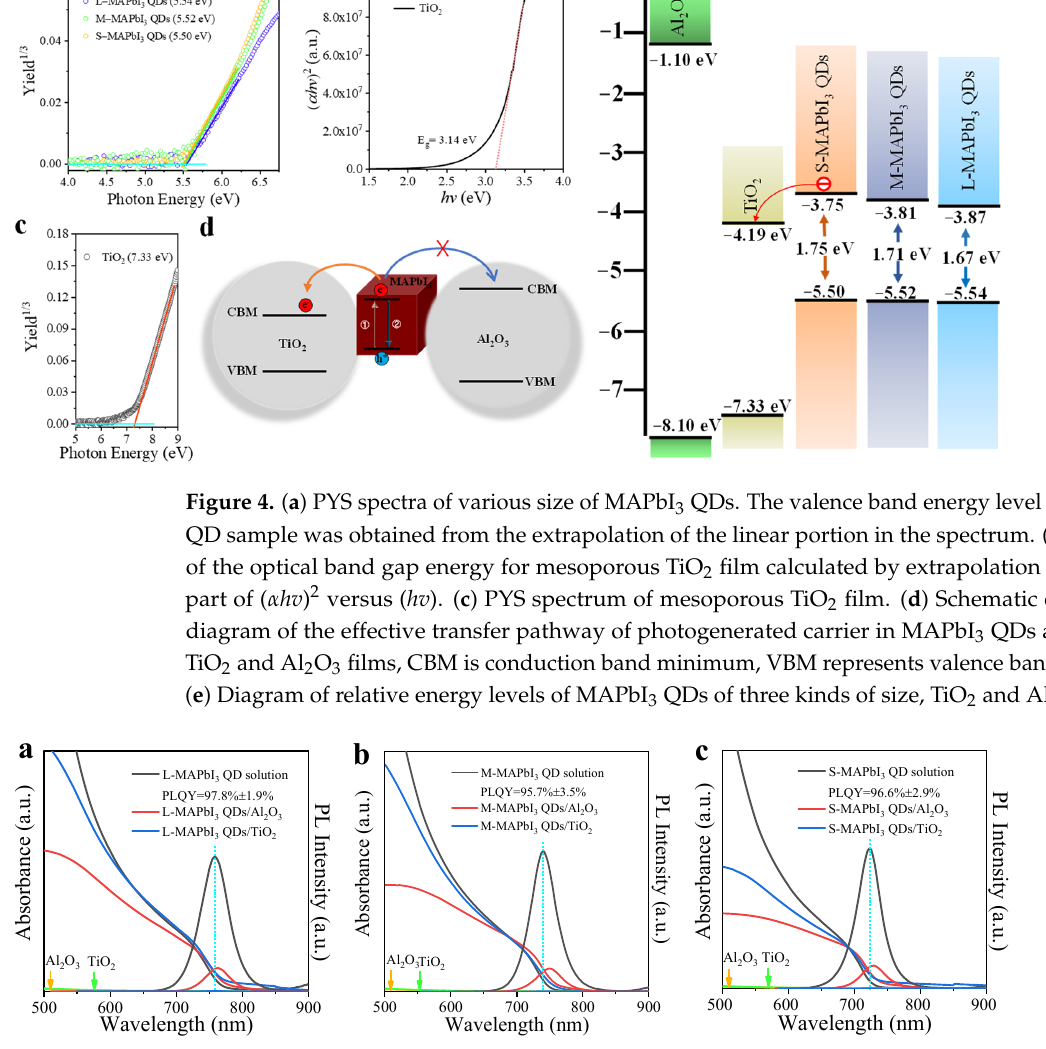
Figure 5. The absorption and PL spectra of ( a ) L-MAPbI 3 QD solution, L-MAPbI 3 QDs/TiO 2 and L- MAPbI 3 QDs/Al 2 O 3 , ( b ) M-MAPbI 3 QD solution, M-MAPbI 3 QDs/TiO 2 and M-MAPbI 3 QDs/Al 2 O 3 , ( c ) S-MAPbI 3 QD solution, S-MAPbI 3 QDs/TiO 2 and S-MAPbI 3 QDs/Al 2 O 3 .